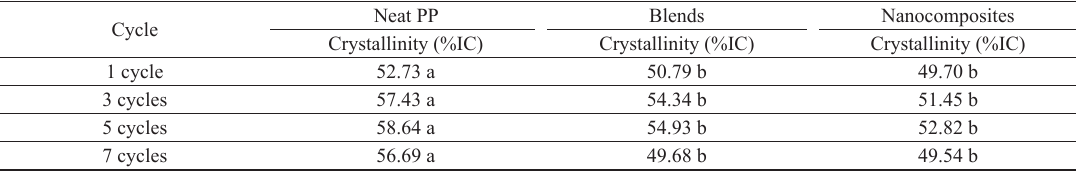
Averages having the same index are not statistically diferente among each other according to the Tukey test t 5% probability.